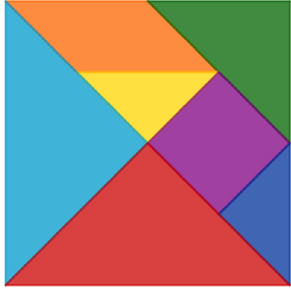
Figure 1. The Tangram pieces.